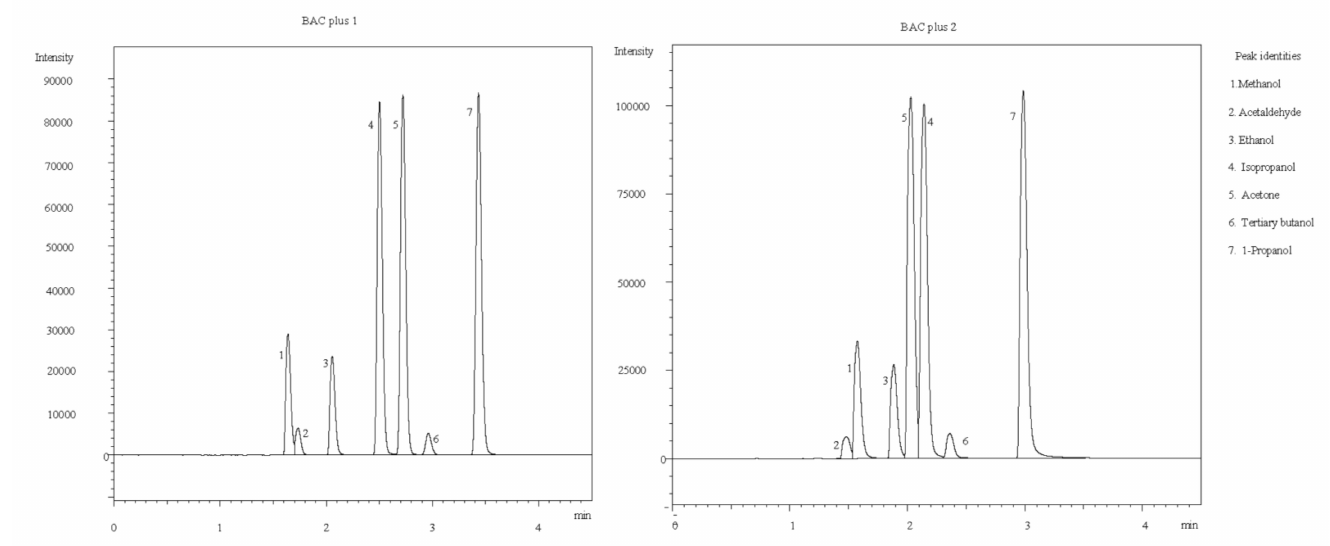
Figure 1. Separation of ethanol from commonly detected alcohols: Both columns demonstrated sufficient separation of ethanol from a range of alcohols, including methanol, isopropanol, tertiary butanol, and 1-propanol, in addition to ethanol’s major metabolite acetaldehyde. Separation of ethanol and acetone was achieved on BAC 1, while BAC 2 demonstrated co-elution with acetone at concentrations greater than 10 mg/mL.